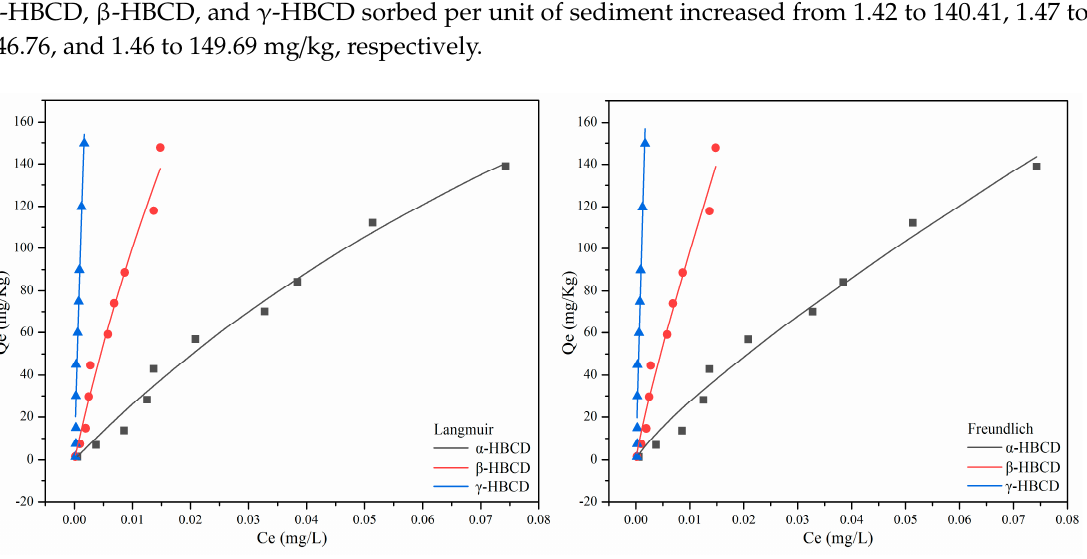
Table 1. Isotherm parameters for HBCDs sorption on sediment.